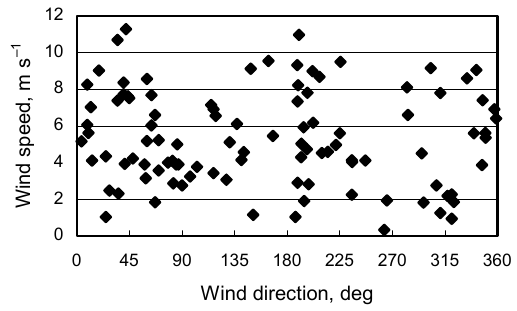
Fig. 5. Wind speed and direction in winter